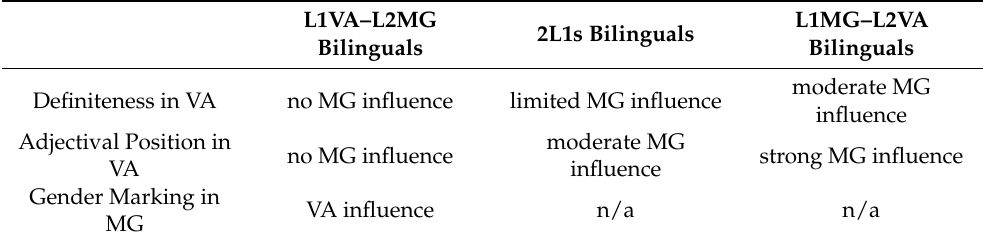
Table 9. Language contact effects in the